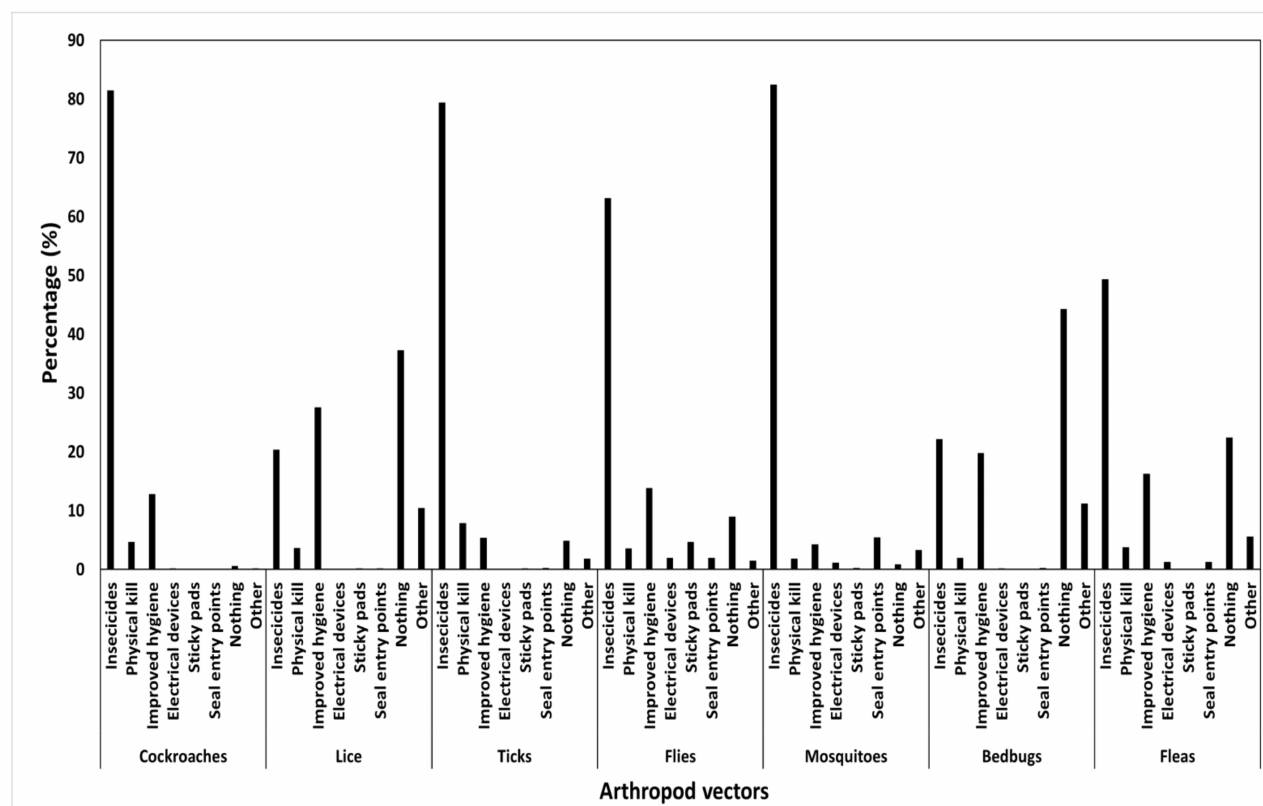
Figure 4. Summary responses (%) showing different ways in which arthropod vectors are controlled within